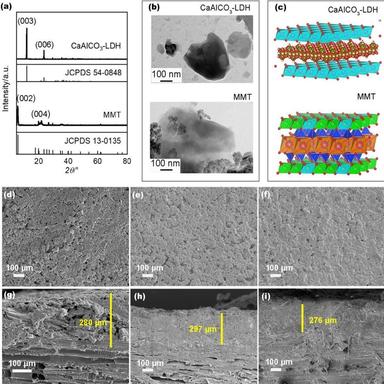
Characterization of the as-synthesised inorganic layered materials. (a) XRD, (b) TEM and (c) lattice structure models. SEM images of the of the fireproof coating samples. (d), (e) and (f) show the surfaces of Binder-IFR, Binder-IFR-LDH and Binder-IFR-MMT, respectively. (g), (h) and (i) show the cross-sections of Binder-IFR, Binder-IFR-LDH and Binder-IFR-MMT, respectively. (A colour version of this figure can be viewed online.)